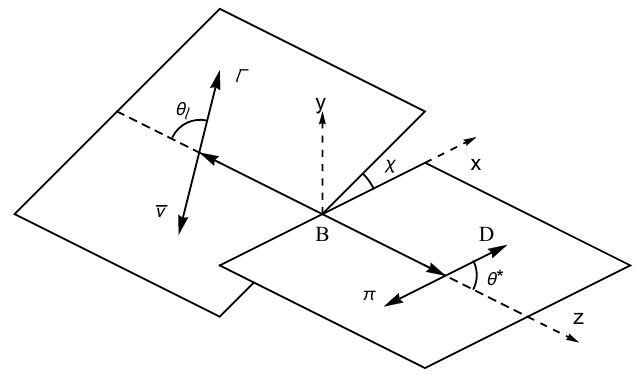
Figure 1 . De(cid:12)nition of the angles in the (cid:22) B ! D (cid:3) ( ! D(cid:25) ) ‘ (cid:0) (cid:22) (cid:23) ‘